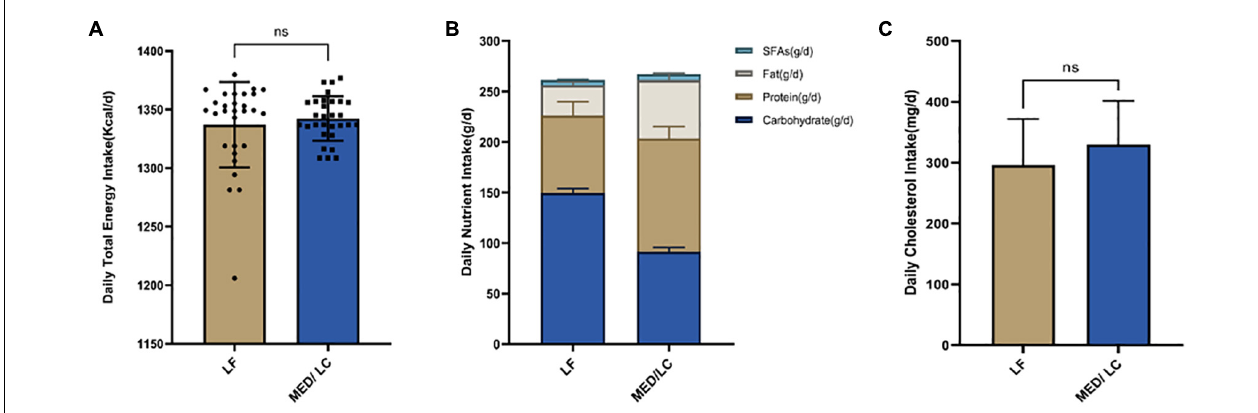
FIGURE 2 | Intake of energy and nutrients between the diet intervention groups. (A) Baseline for daily total energy intake remained the same for both groups( P > 0.05). (B) The Mediterranean/low-carbohydrate (MED/LC) diet more greatly decreased the intake of carbohydrate and more greatly increased the intake of protein, fat and saturated fatty acids (SFAs). (C) No difference in daily cholesterol intake between the two groups( P > 0.05). Analysis of variance with a covariance (ANCOVA) test was used. LF, low fat diet.